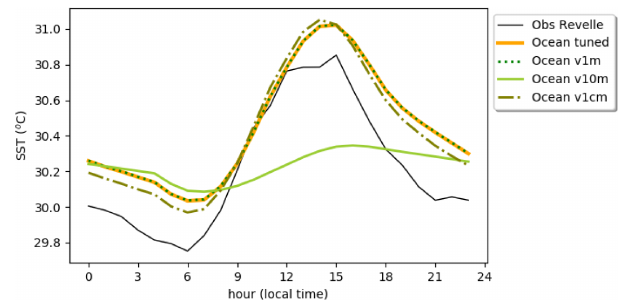
Figure 8. Mean daily cycle of surface temperature ( ◦ C) for the ref- erence ocean forced experiment (orange) and sensitivity tests to the ocean vertical discretization (green).